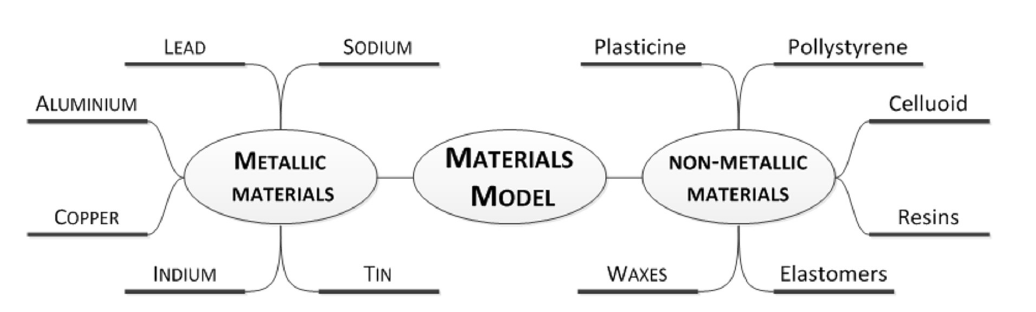
Figure 1: Types of model